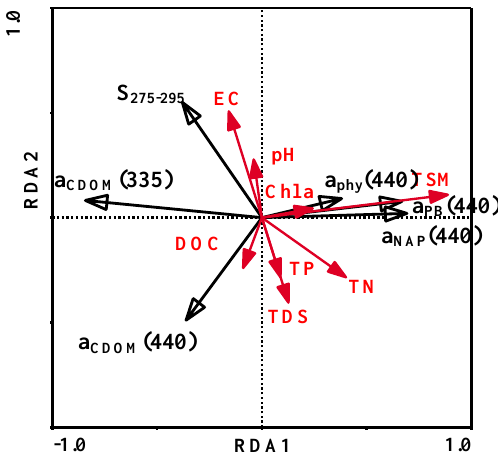
Figure 6. RDA of CDOM adsorption data and water quality param- eters ( n =